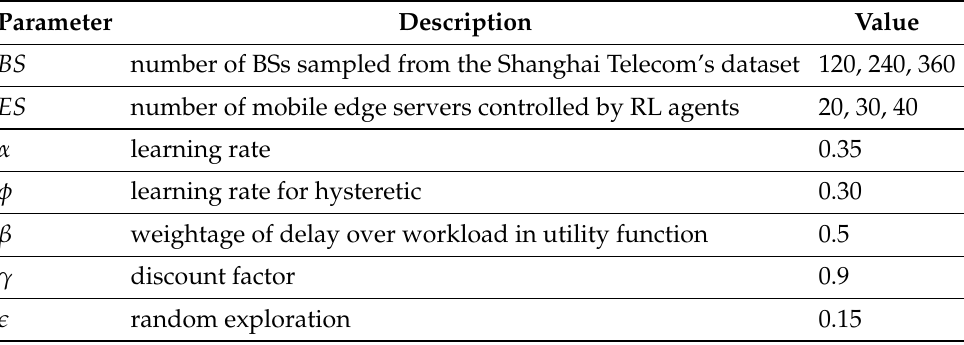
Table 1. Simulation